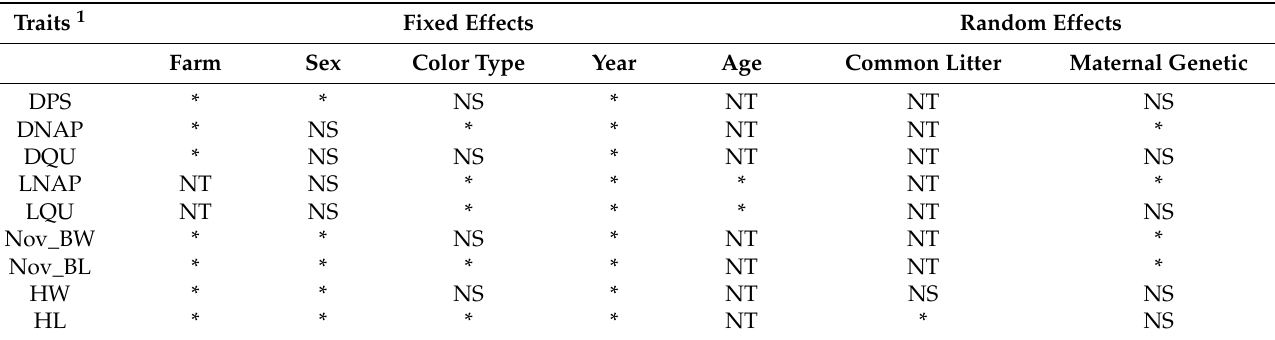
Table 1. Significance of fixed and random effects included in the models for dried pelt, live grading and body weight and length traits in